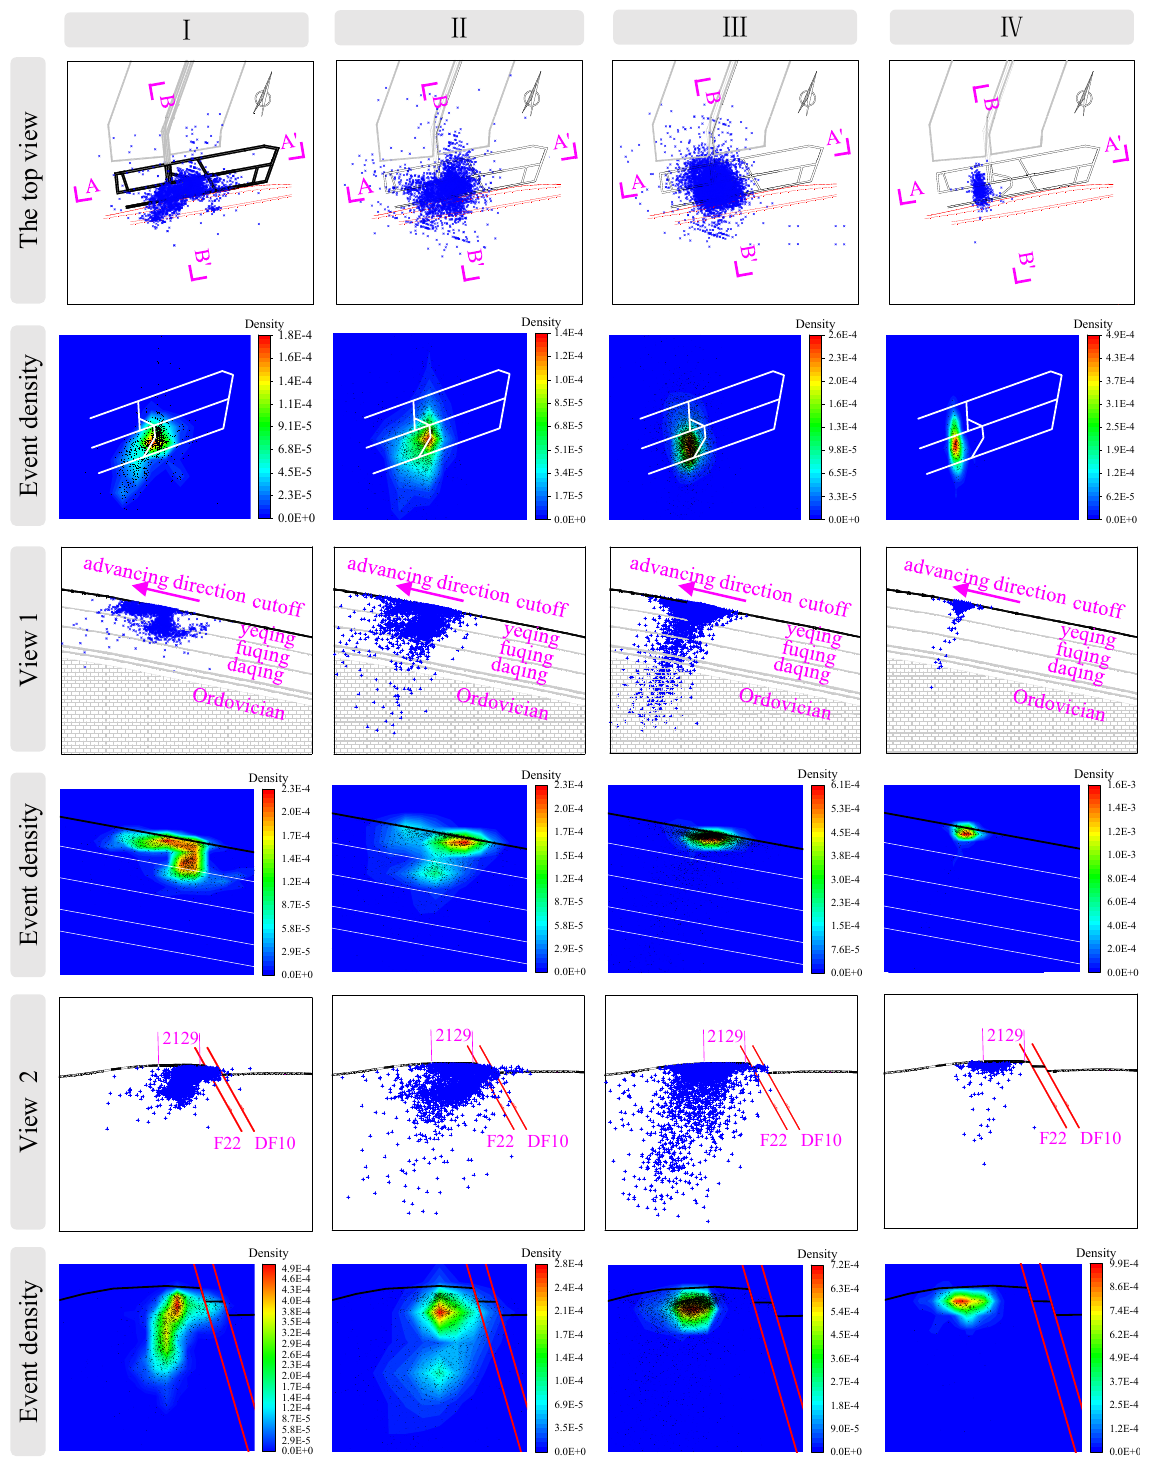
Figure 13. Development of seismic events.